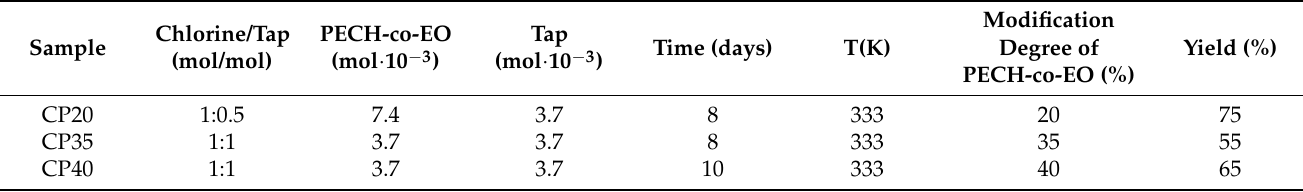
Table 1. Reaction conditions and resulting modification degrees and yields for the P(ECH-co-EO) modification with Tap.